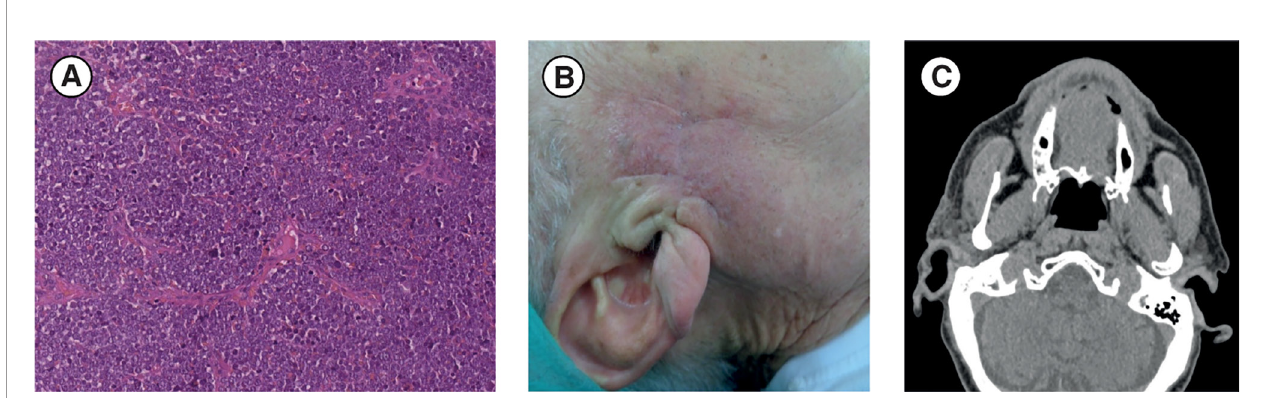
FIGURE 1 | (A) Diagnosis: histological image of hematoxylin and eosin. section (scale bar: 50 µm) shows small tumor cells with a round-oval nucleus and poor cytoplasm that are very densely arranged in a diffuse pattern of growth. (B, C) Post-debulking surgery restaging: (B) Post-debulking clinical presentation with a purplish lesion (approximately 1.5 × 1.5 cm) situated near the right preauricular region close to the surgical scar. (C) Face and neck CT scan (axial projection) showing residual disease in the right preauricular region. CT,